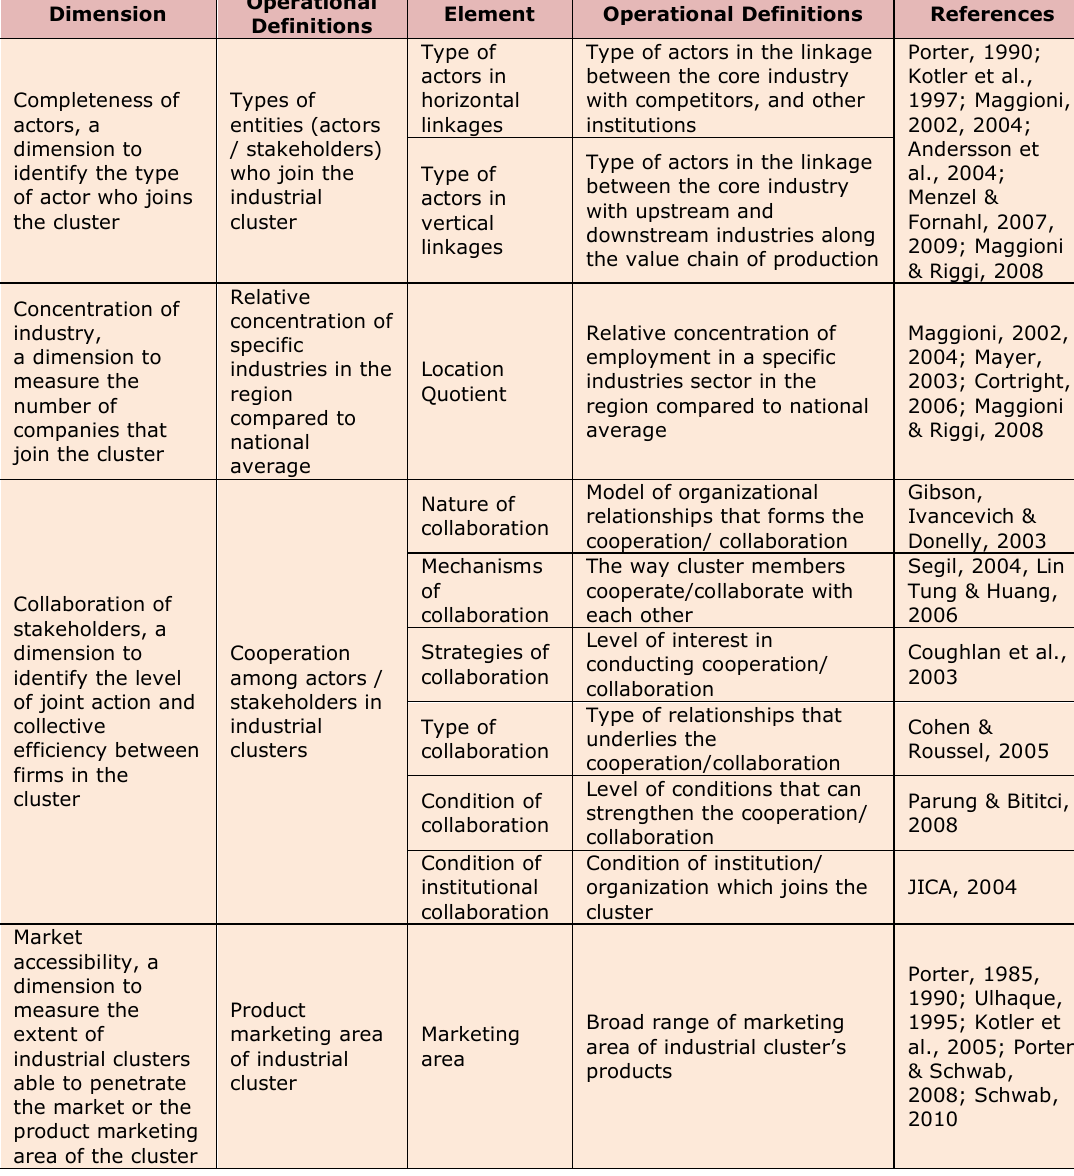
Table 7. Operational definitions of dimensions and elements to identify phases of